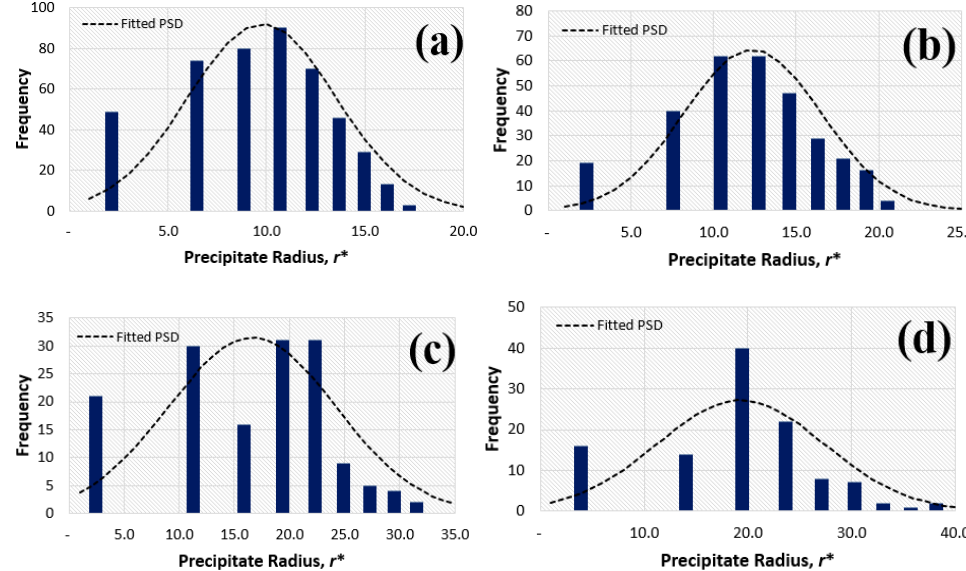
Figure 8. Histograms of the PSD in presence of 20% nanoparticles of size 10 at different times, t *,